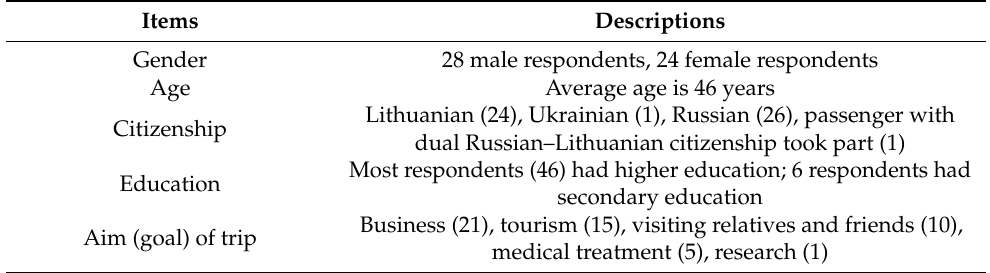
Table 1. Details of 52 respondents who gave the judgement on